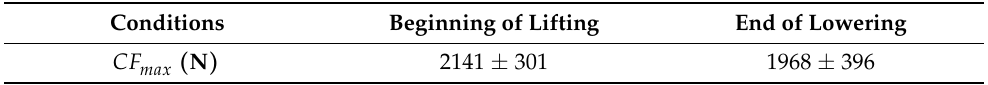
Table 1. Maximum of the CF in the beginning of lifting and the end of lowering of the PT task (Mann-Whitney test shows p -value = 0.025).